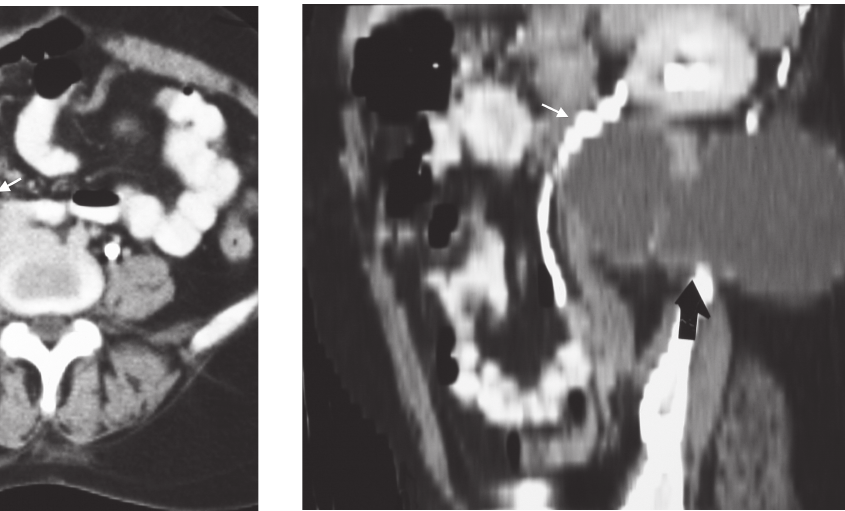
figure 1 - Post-contrast axial CT demonstrating a medially displaced right ureter (white arrow) splayed around non- enhancing cystic retroperitoneal masses (*); herniated cyst (black arrow).